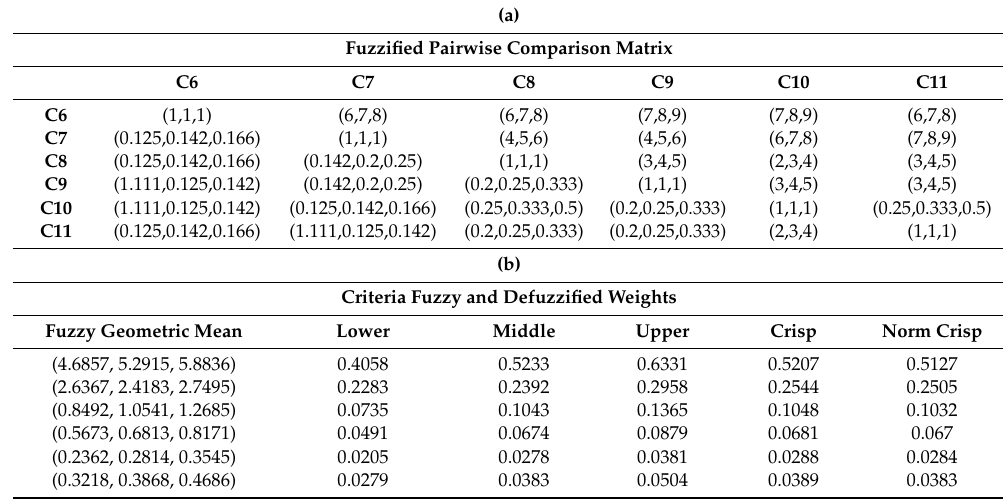
Table 7. SF-AHP results per criteria category for the category economic. ( a ) Fuzzified pairwise comparison matrix; ( b ) Criteria fuzzy and defuzzified weights.